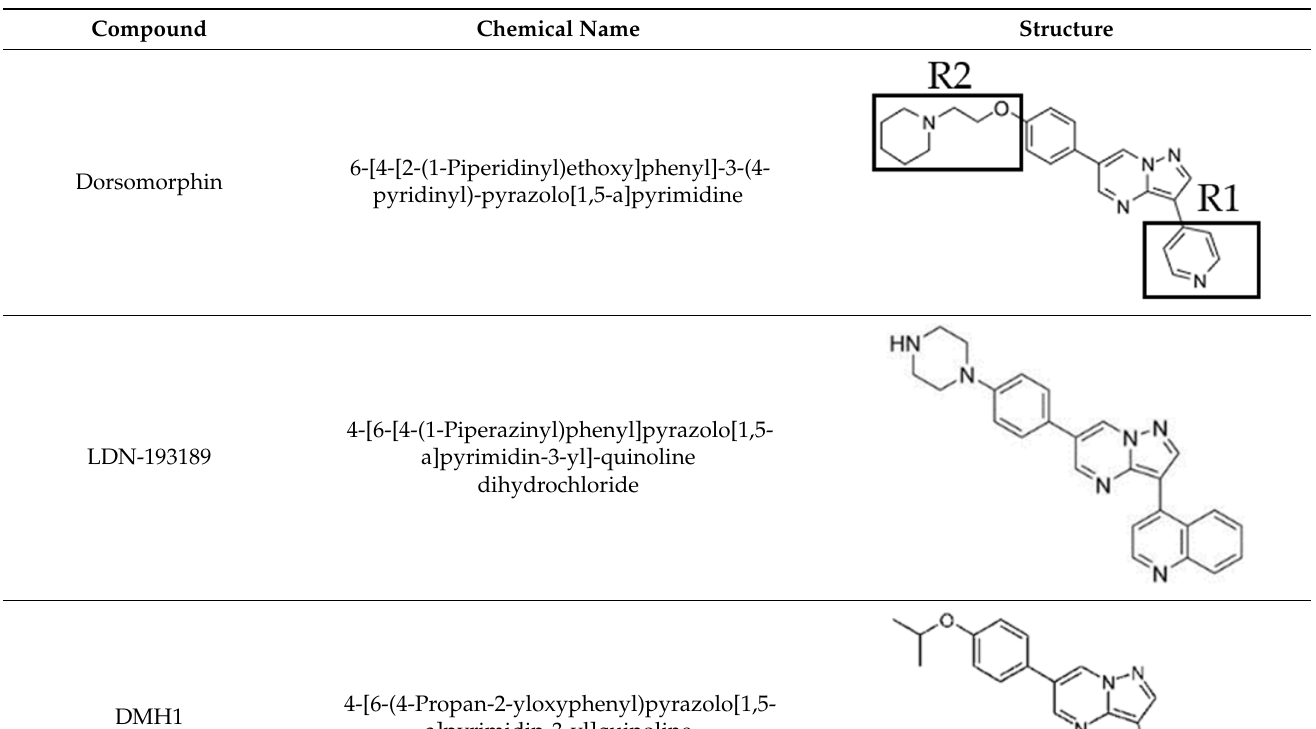
Table 1. Small-molecule BMP inhibitors: Chemical Names and Structures.